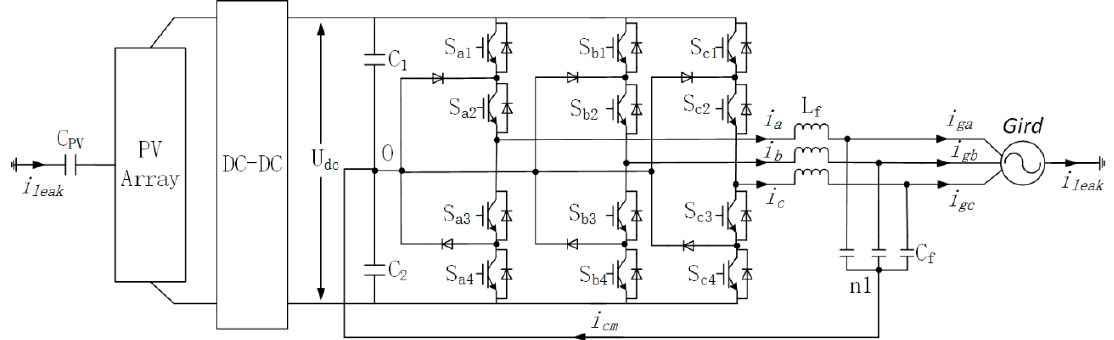
Figure 1. Grid-connected transformer less three-level I-type inverter with ILC filter.